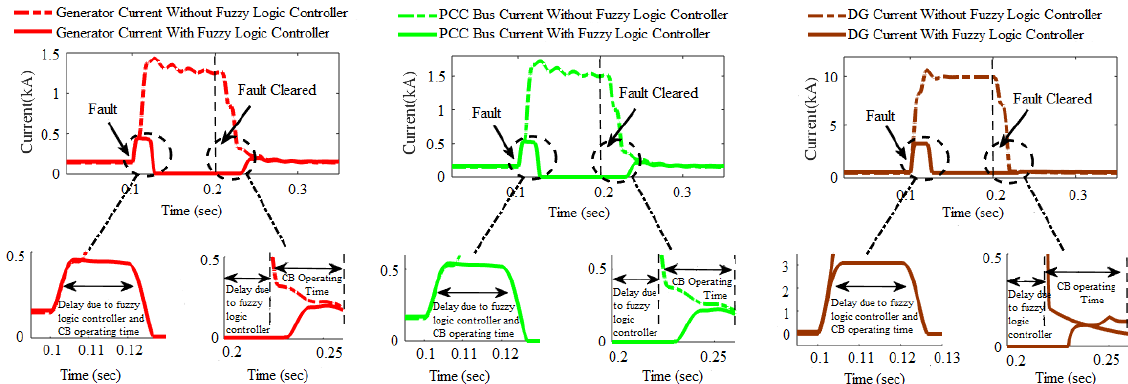
Figure 12. Current flows from different power system actors when fault occurs near the load center with the proposed energy management system using the fuzzy inference system. The dotted plots illustrate the short circuit current with no energy management strategy being active.